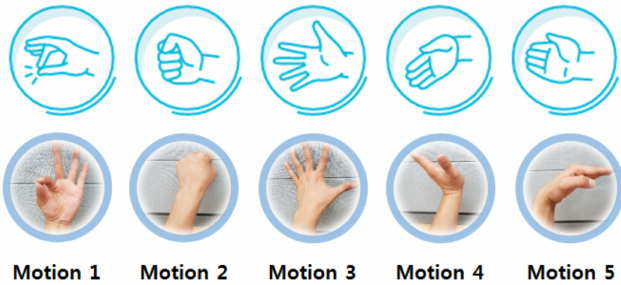
Figure 13. The five gestures provided by